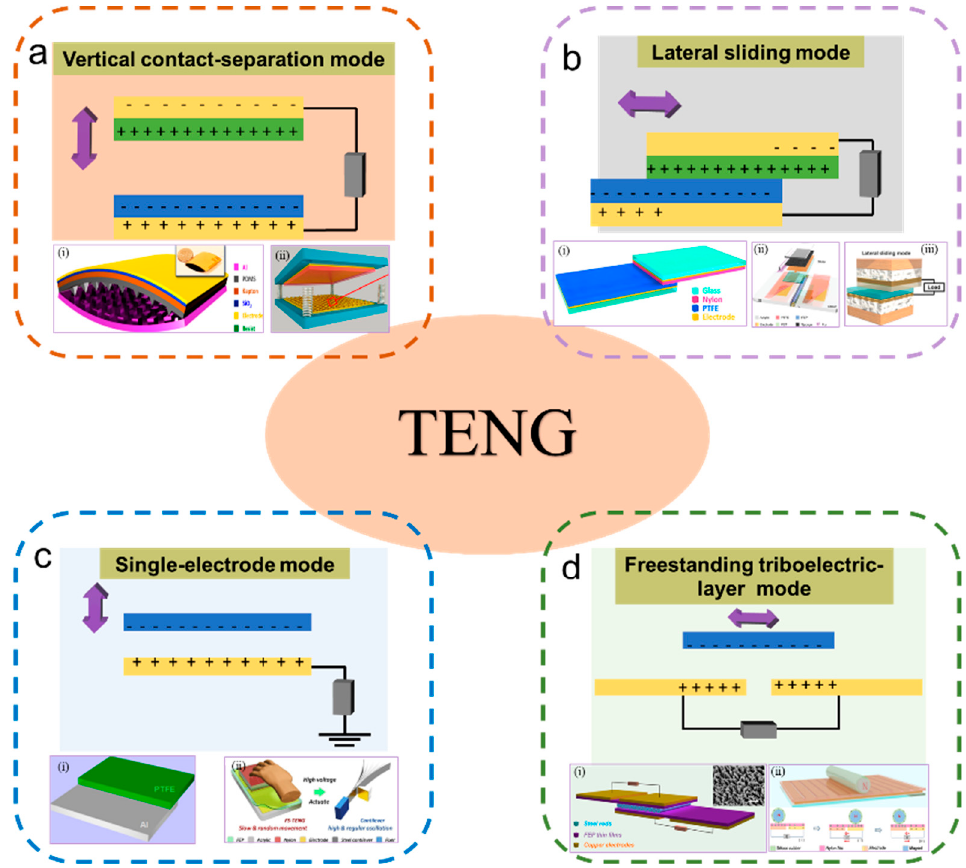
Figure 2. The four fundamental modes of triboelectric nanogenerators and several typical cases of them. ( a ) Vertical contact–separation mode. Reproduced with permission [19]. Copyright 2012,